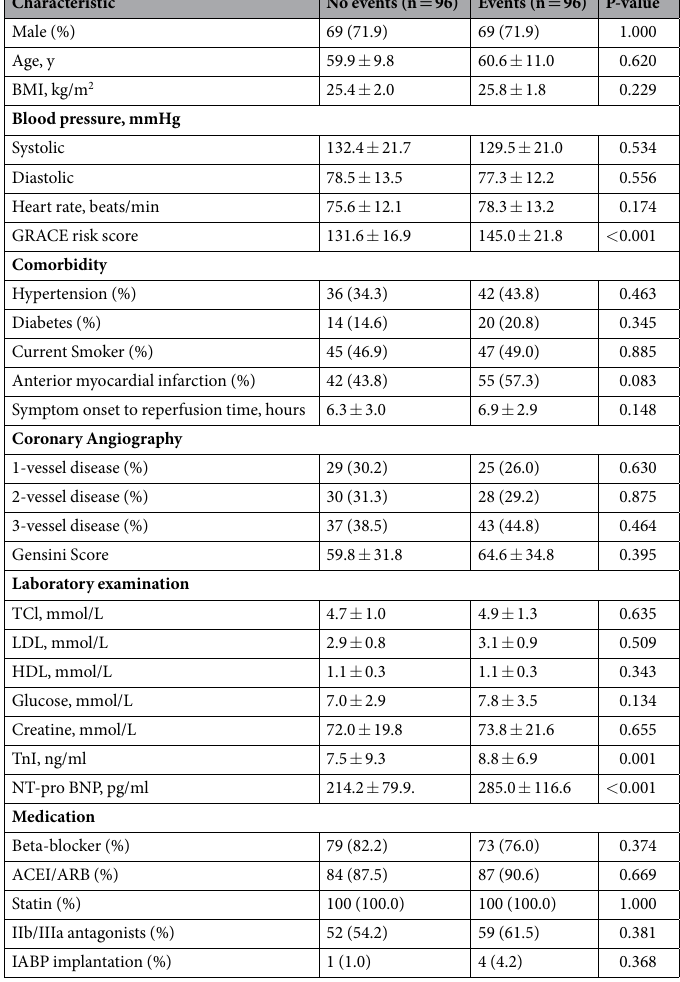
Table 1. Baseline clinical characteristics of study patients. Data are presented as mean ± standard deviation or number (%). P values derived from Mann–Whitney U -tests or χ 2 tests for continuous and categorical variables, respectively. ACEI = angiotensin-converting enzyme inhibitor; ARB = angiotensin receptor blocker; BMI = body mass index; GRACE = Global Registry of Acute Coronary Events; HDL = high-density lipoprotein; IABP = intra-aortic balloon pump; LDL = low-density lipoprotein; NT-pro BNP = N-terminal pro-B-type natriuretic peptide; TC = total cholesterol; TnI = troponin